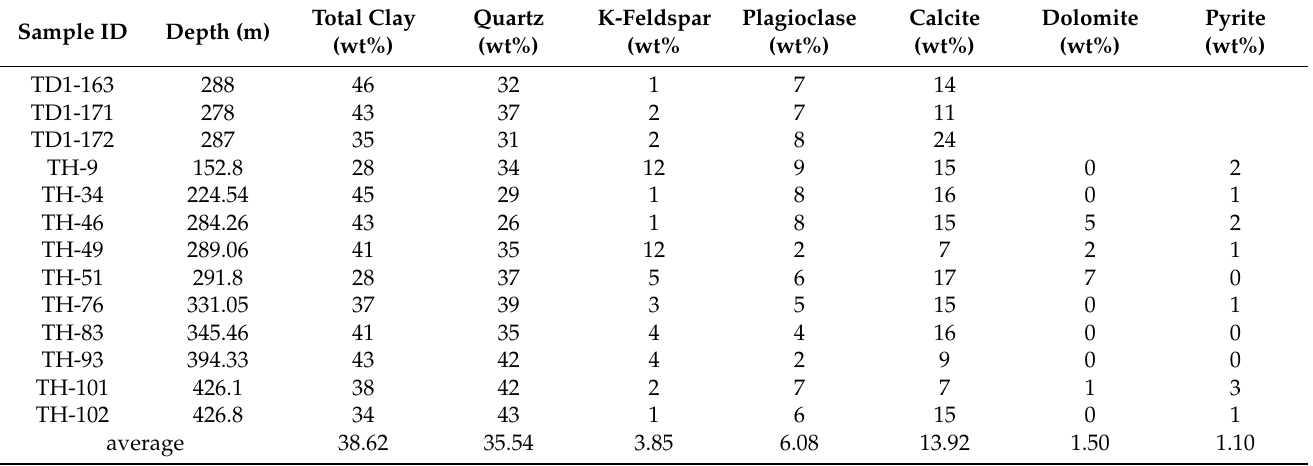
Table 1. Parameters of the XRD results of the samples from the Hengtongshan